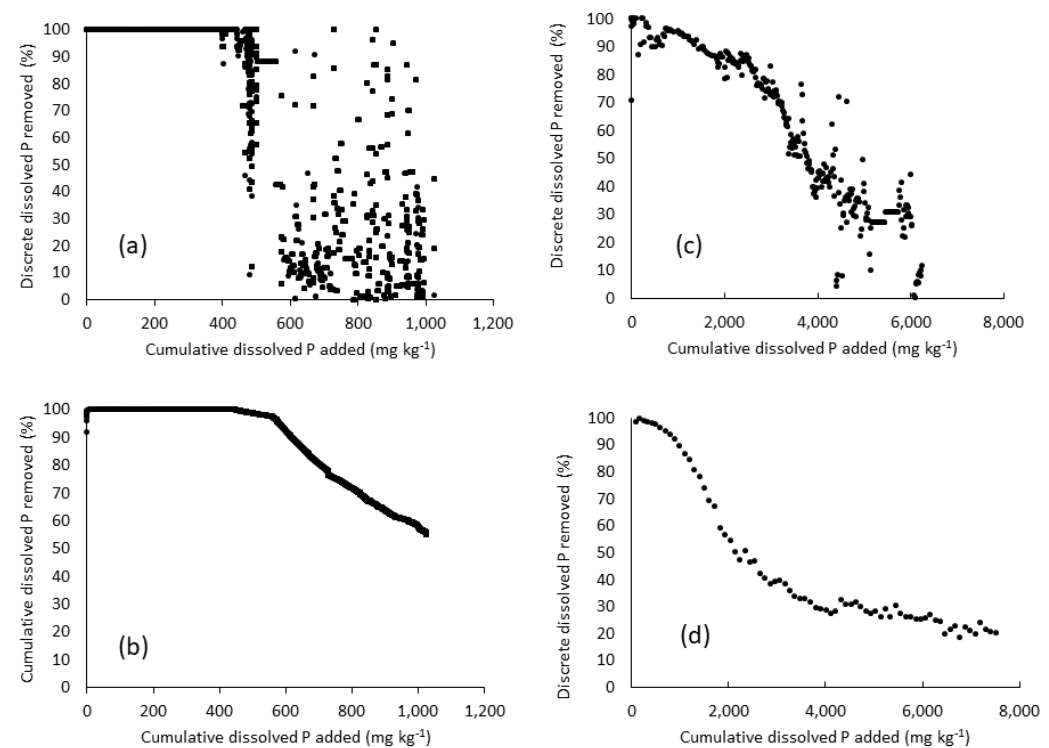
Figure 5. Discrete ( a ) and cumulative ( b ) dissolved phosphorus (P) removal by the subsurface tile drain P removal structure as a function of cumulative dissolved P loading to the slag media. Laboratory flow-through discrete P removal curves for the same slag sample are shown in ( c ) and ( d ) for comparisons to field performance under the conditions of a ten-minute retention time and inflow dissolved P concentrations of 0.5 and 2 mg L − 1 ( c and d , respectively). Discrete dissolved P removal for the structure ( a ) is shown excluding negative values in order to improve clarity, but cumulative dissolved and total P removal ( b ) is calculated with inclusion of those negative values. Note that the horizontal axes scales for ( a ) and ( b ) are different from ( c ) and ( d ).